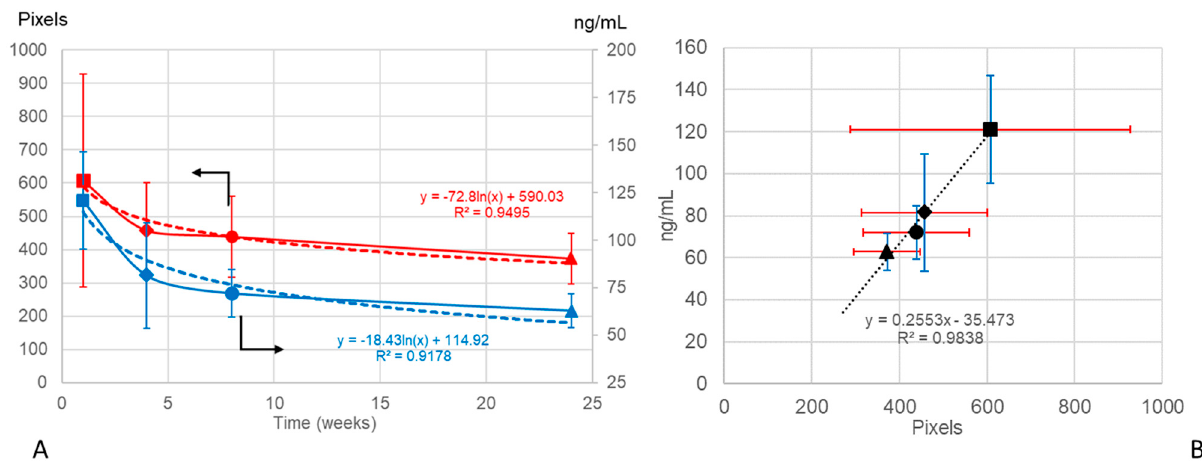
Figure 7. ( A ) Decreasing brimonidine level curves in rat eyes expressed in ng/mL (mean ± standard deviation; n = 3 eyes in each study time) (data from [9] (CC BY 4.0 license)) (in blue) and total aggregate area in the rat eye vitreous expressed in pixels (mean ± standard deviation; n = 9 eyes at week 1, n = 21 eyes at week 4, n = 8 eyes at week 8 and n = 5 eyes at week 24), obtained using optical coherence tomography (in red) over 24 weeks of follow-up. Logarithmic curves in dashes. ( B ) Positive linear correlation between drug levels and total aggregate area. Data are expressed as means ± standard deviation; optical coherence tomography (OCT) data in red; brimonidine data in blue; (cid:4) : 1 week; (cid:7) : 4 weeks; • : 8 weeks; (cid:78) : 24 weeks.